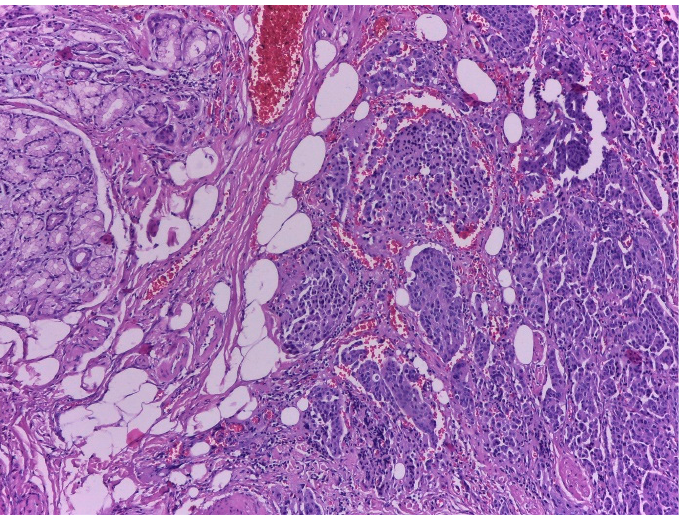
Figure 6. Well differentiated NEN located in the duodenal wall in Hematoxylin and eosin stain, ×100.